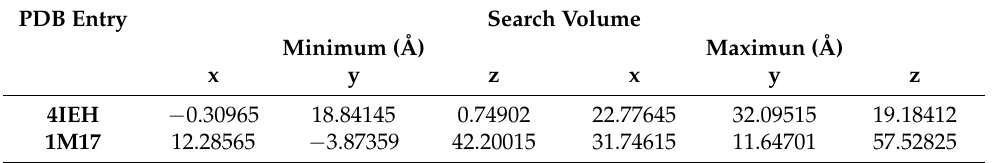
Table 3. Search volume for molecular docking.